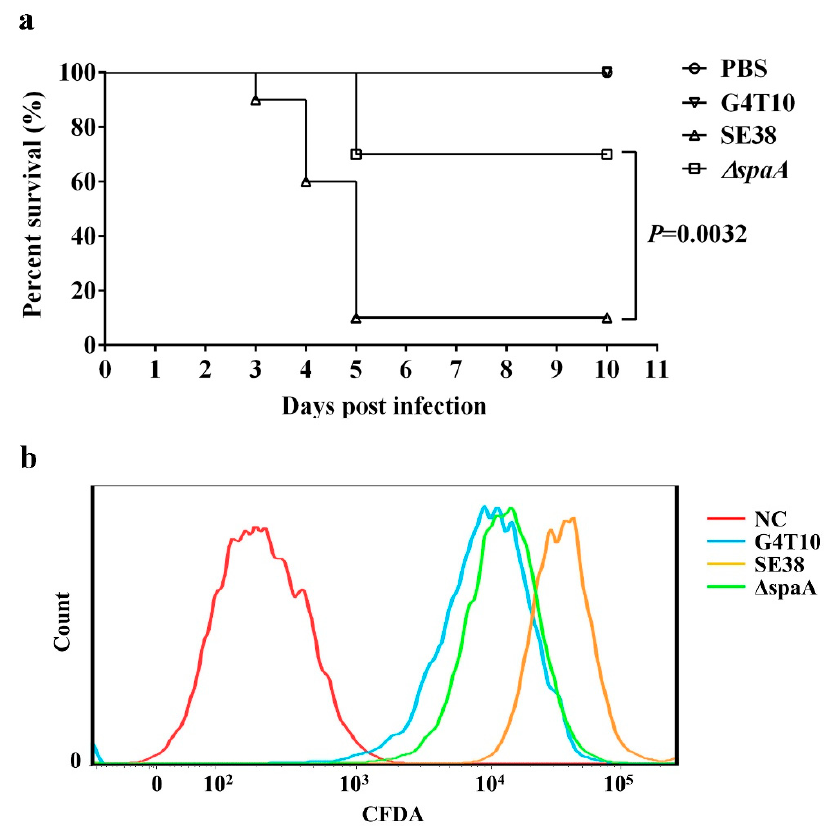
Figure 4. Evaluation of the virulence and adhesion ability of ∆ spaA . ( a ) Mouse survival rate. C57BL/6 mice were subcutaneously challenged with 500 µ L of attenuated strain G4T10, WT strain SE38, mutant strain ∆ spaA , or PBS (10 mice/group). ( b ) Flow cytometry analysis. G4T10, SE38, and ∆ spaA were labeled with CFDA-SE, and then co-incubated with PIECs (100:1 ratio) at 37 ◦ C for 2 h. Flow cytometry was performed with a total of 10,000 cells counted in each group. Survival assay statistics were conducted using the log-rank (Mantel-Cox) test. All experiments were performed at least twice under similar conditions and yielded similar results.